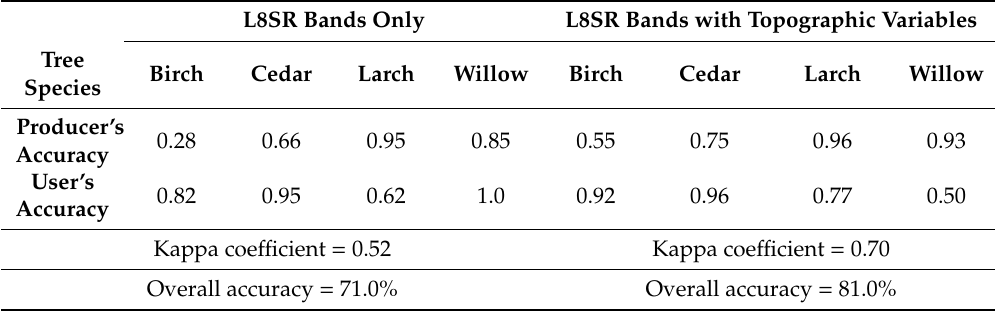
Table 5. Tree species classification accuracy